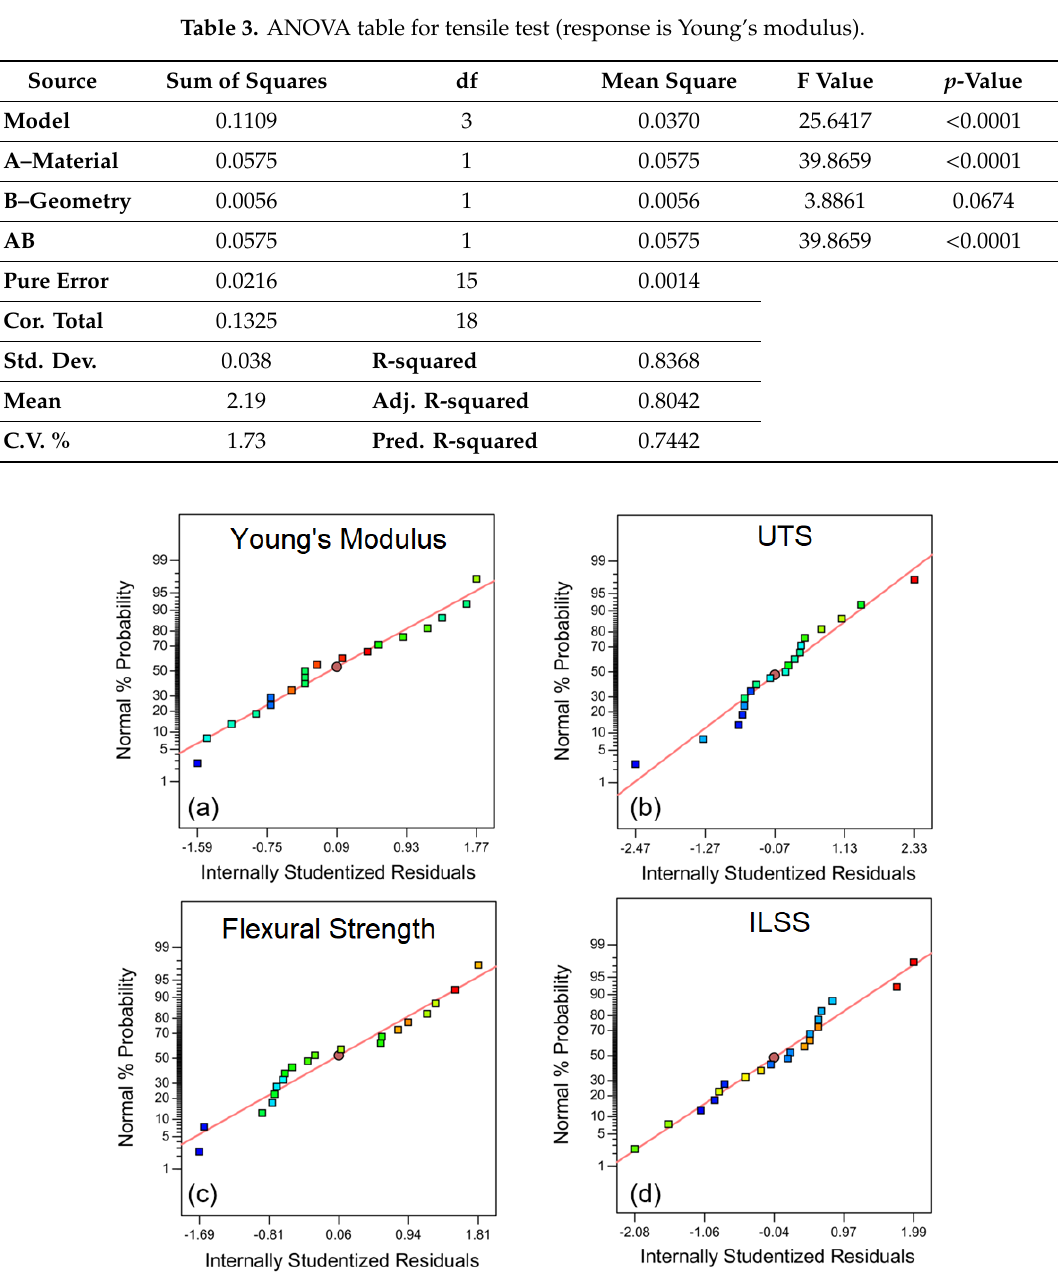
Figure 6. Normal probability plot for: ( a ) Young’s modulus; ( b ) ultimate tensile strength; ( c ) flexural strength; and ( d ) interlaminar shear strength.